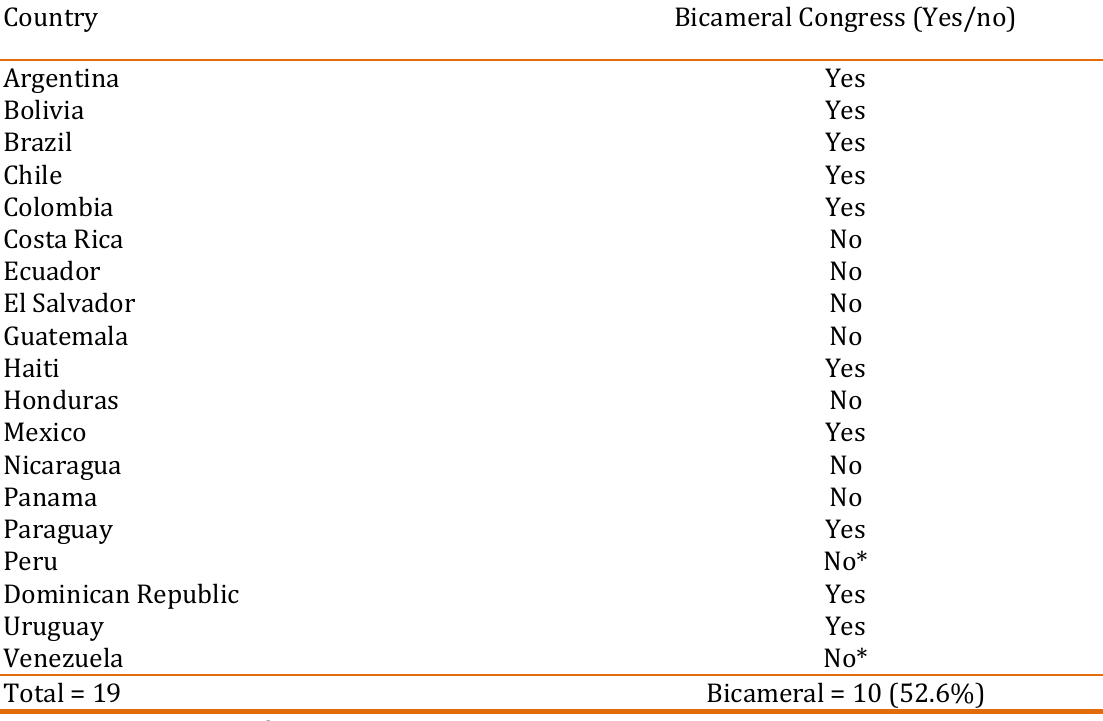
Table 01. Bicameralism in Latin America Country Bicameral Congress